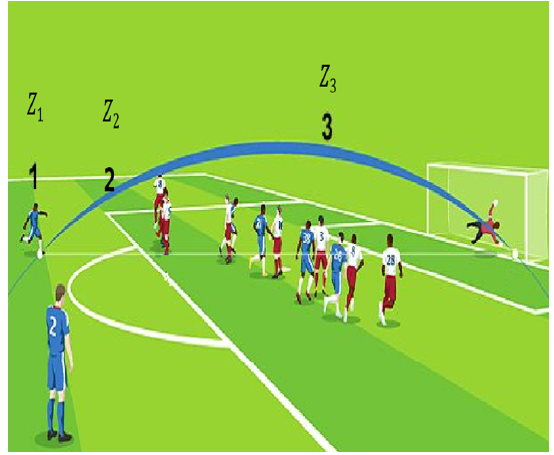
Figure 2. Height of the ball on the vertical axis Z .